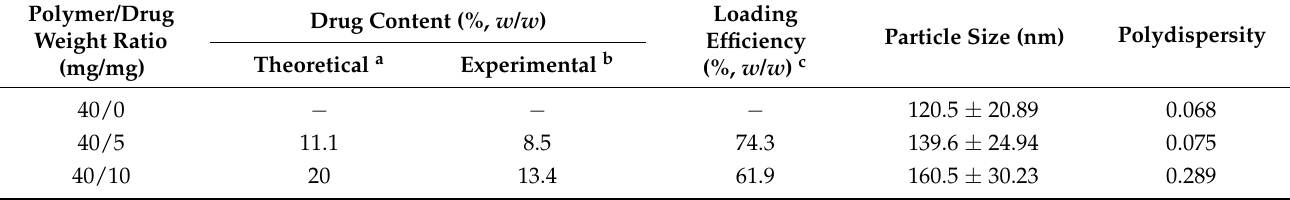
Table 1. Drug content and particle size of DOX-incorporated ChitoHISss